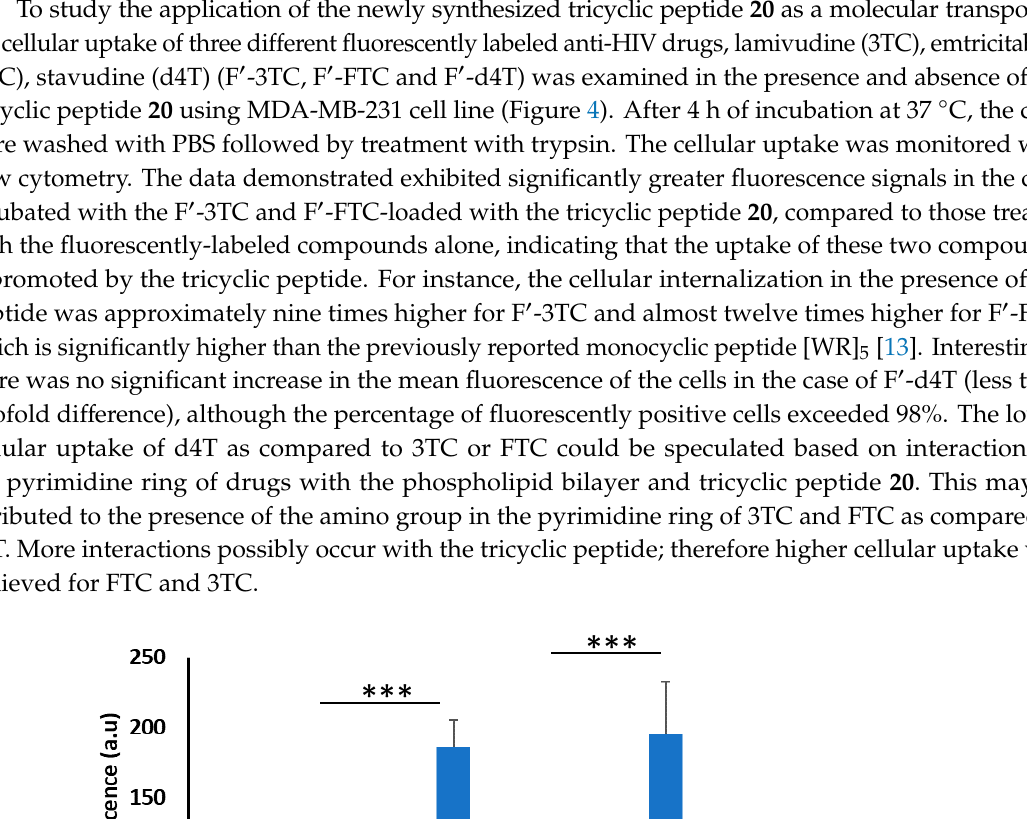
Figure 3. The cellular uptake of fluorescently labeled G-(pTyr)-Glu-Glu-Ile (F ′ -GpYEEI) using tricyclic peptide 20 in the MDA-MB-231 cells (if p < 0.0001 then ****). Untreated cells are shown on the left.